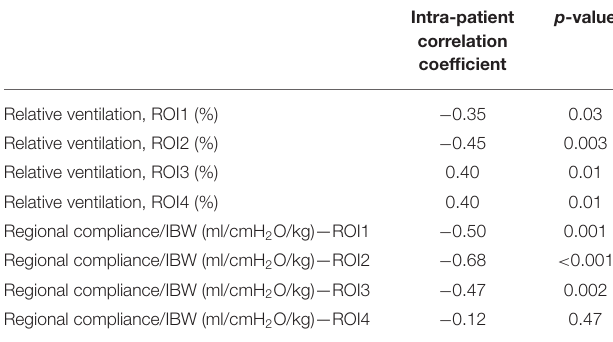
impedance tomography (EIT)- derived and esophageal-derived parameters. Intra-patient correlation